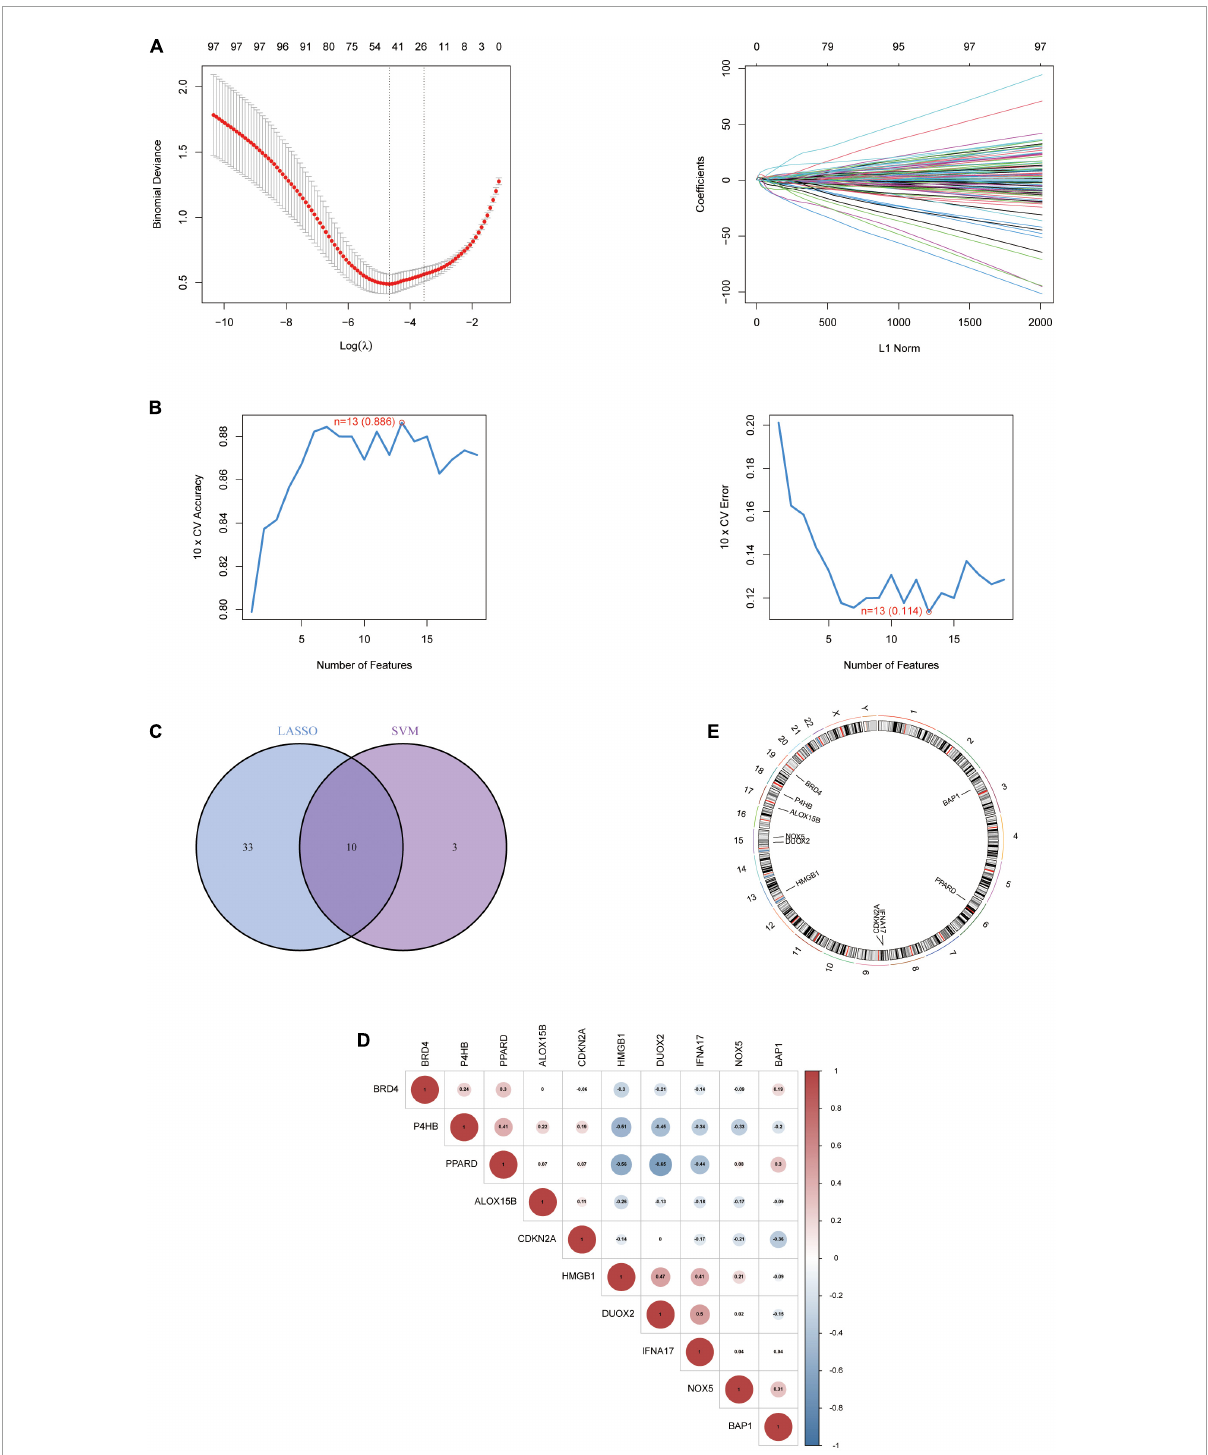
FIGURE3 The identification of 10 Hub genes. (A) The LASSO logistic regression algorithm identified 43 AD-related features with a 10-fold cross-validation set for selecting the penalty parameter to determine the optimal lambda value. (B) A total of 13 feature genes were filtered out using the mSVM-RFE algorithm. (C) Venn diagram of genes extracted from LASSO and mSVM-RFE methods. (D) Heatmap of correlations for Hub genes. Positive correlations are marked in red and negative correlations are marked in blue. The numbers in the middle represent correlation coefficients. (E) Map of the location of the Hub gene on the chromosome. LASSO, least absolute shrinkage and selection operator; SVM, support vector machine; RFE, recursive feature